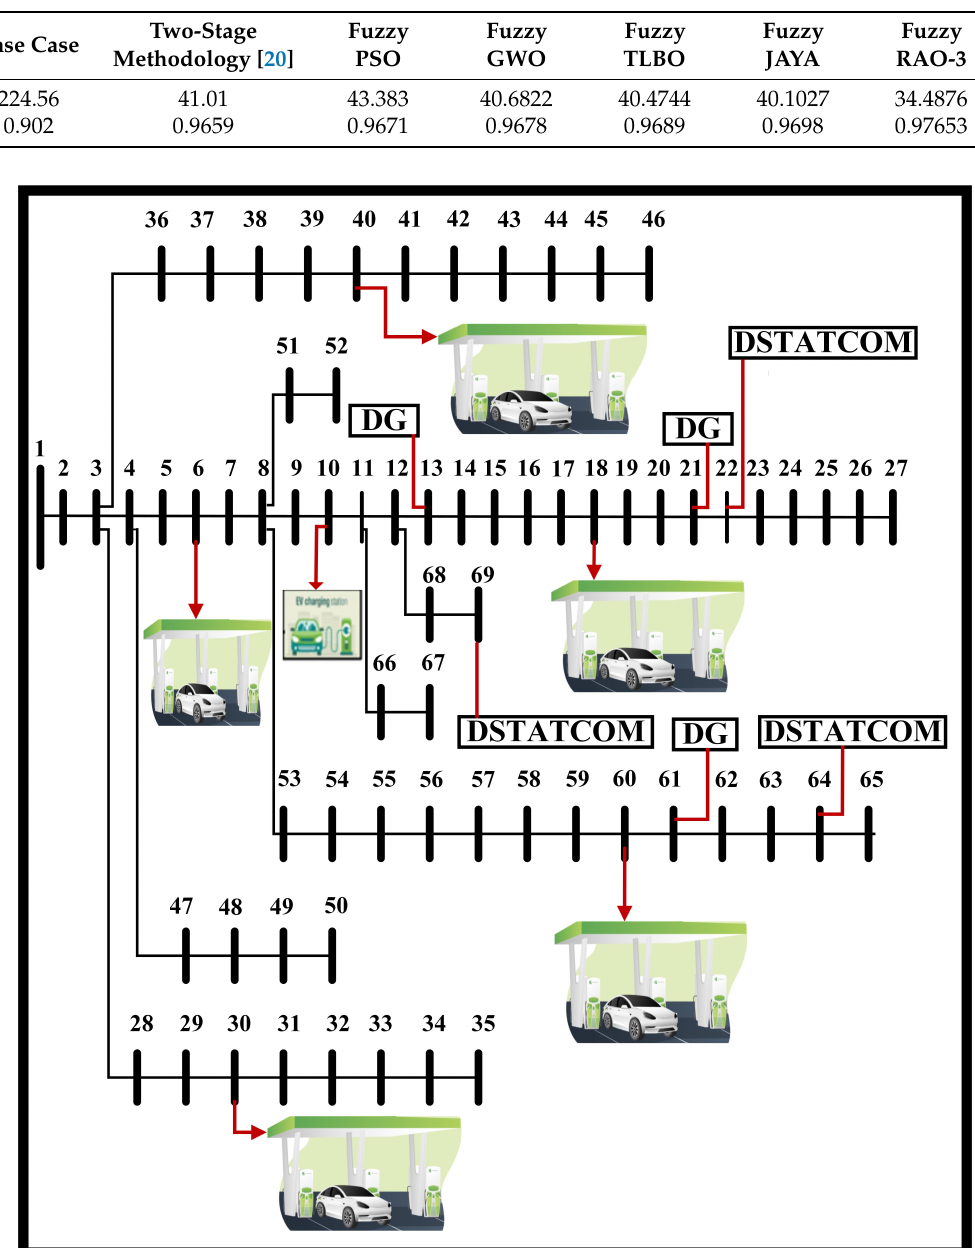
Table 6. Performance of the 69-bus radial distribution system after installation of the EVCS.